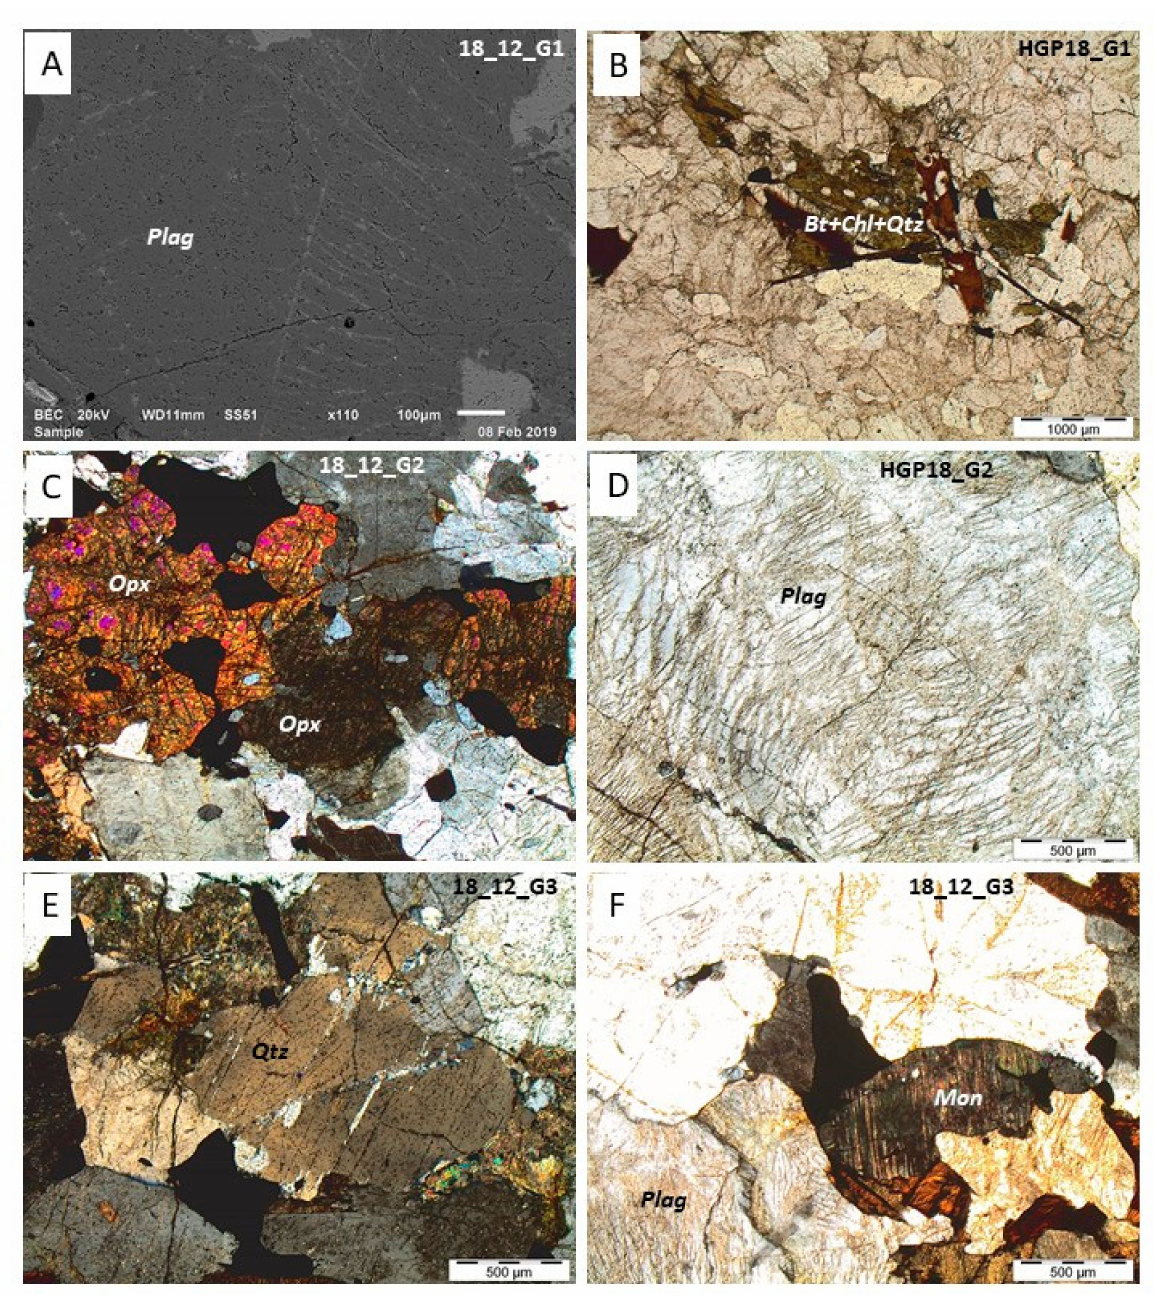
Figure 9. ( A ) Backscattered electron (BSE) image of plagioclase in sample 18_12_G1. ( B ) Sample HGP18_G1 in plane- polarized light (PPL). ( C ) Orthopyroxene crystals (high interference color) with apatite (grey crystals enclosed in Opx) in sample 18_12_G2 in crossed-polarized light (XPL). Scale as in (B). ( D ) Plagioclase with “feather” features in sample HGP18_G2 (PPL). ( E ) Recrystallization along the planar deformation features (PDFs) in quartz in sample 18_12_G3 (XPL). ( F ) Chocked monazite found in sample 18_12_G3 (XPL). Planar microstructures extended in the N–S direction. Bt: biotite, Chl: chlorite, Mon: monazite, Opx: orthopyroxene, Plag: plagioclase, Qtz: